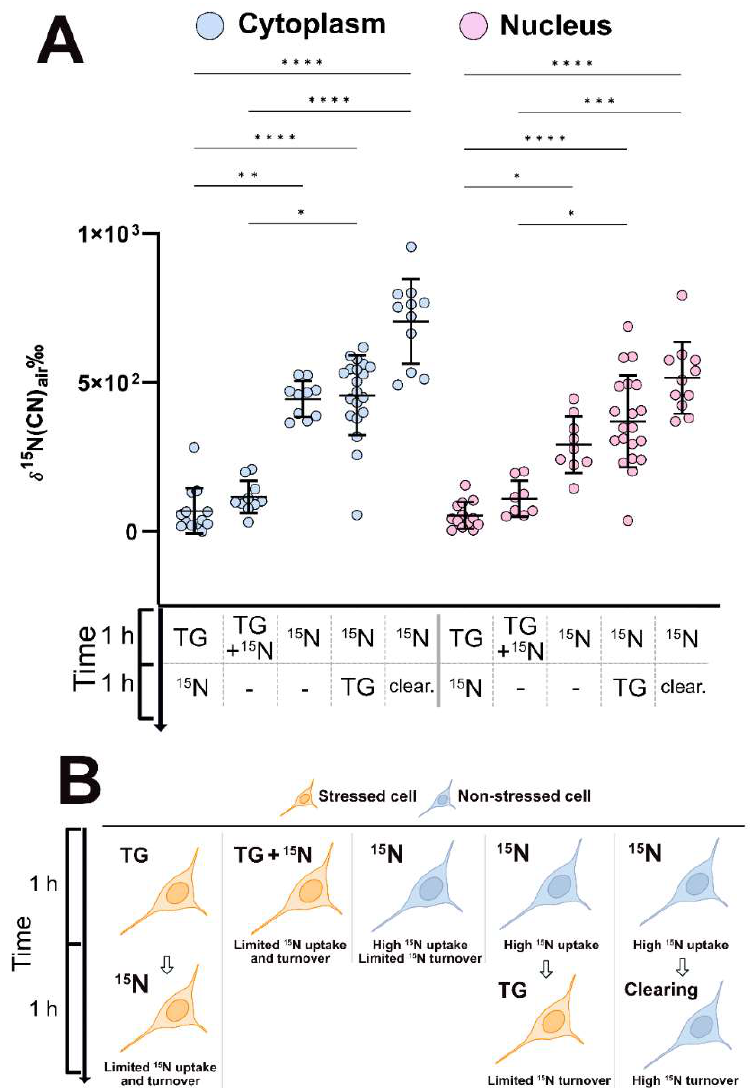
Figure 2. Subcellular protein turnover under the effect of ER stress. 15 N enrichments in the cytoplasm and nucleus are significantly different between the stressed and non-stressed cells. ( A ) From left to right, for both cytoplasm (blue) and nucleus (pink): cells that had stress followed by 15 N leucine incubation ( TG → 15 N , n = 13), 15 N leucine incubation and stress at the same time ( TG + 15 N , n = 10), only 15 N leucine incubation ( 15 N, n = 10), 15 N leucine incubation followed by stress ( 15 N → TG , n = 20), and 15 N leucine incubation followed by clearing ( 15 N , clear. , n = 11). A one-way non-parametric ANOVA finds statistical differences between the means of at least two groups in the cytoplasm and nucleus data, separately (Dunn ´ s, * p < 0.005, ** p < 0.01, *** p < 0.001, **** p < 0.0001); n refers to the number of cells. ( B ) Schematics of cell treatment with 15 N incubation and TG